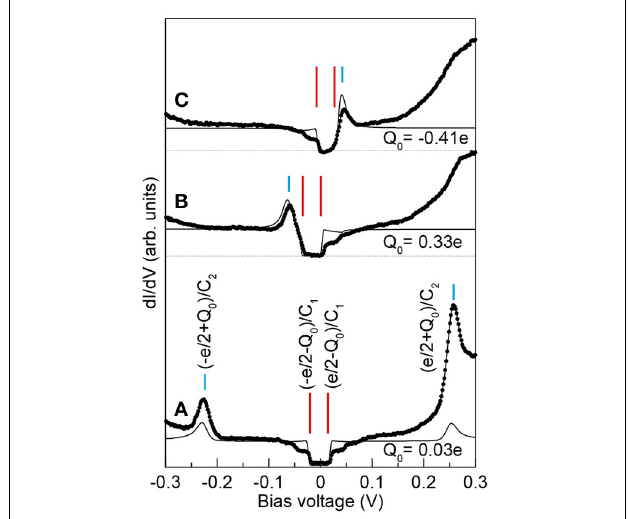
FIGURE 5 | Spectra (A to D): increase of the tip-island capacitance C 2 with decreasing tip-island distance (increasing tunnel current). The spectra, offset for clarity as dI / dV ( 0 V ) = 0, have been acquired on a Pb island of 14nm side. Parameters of the simulation, performed for spectra (A) and (D) curve: C 1 = 5 . 0aF, C 2 = 0 . 77aF, R 1 = 5M (cid:3) , R 2 = 1700M (cid:3) , Q 0 = 0 . 062 e ; (D) curve: C 1 = 5 . 0aF, C 2 = 0 . 86aF, R 1 = 5M (cid:3) , R 2 = 145M (cid:3) , Q 0 = 0 . 07 e .